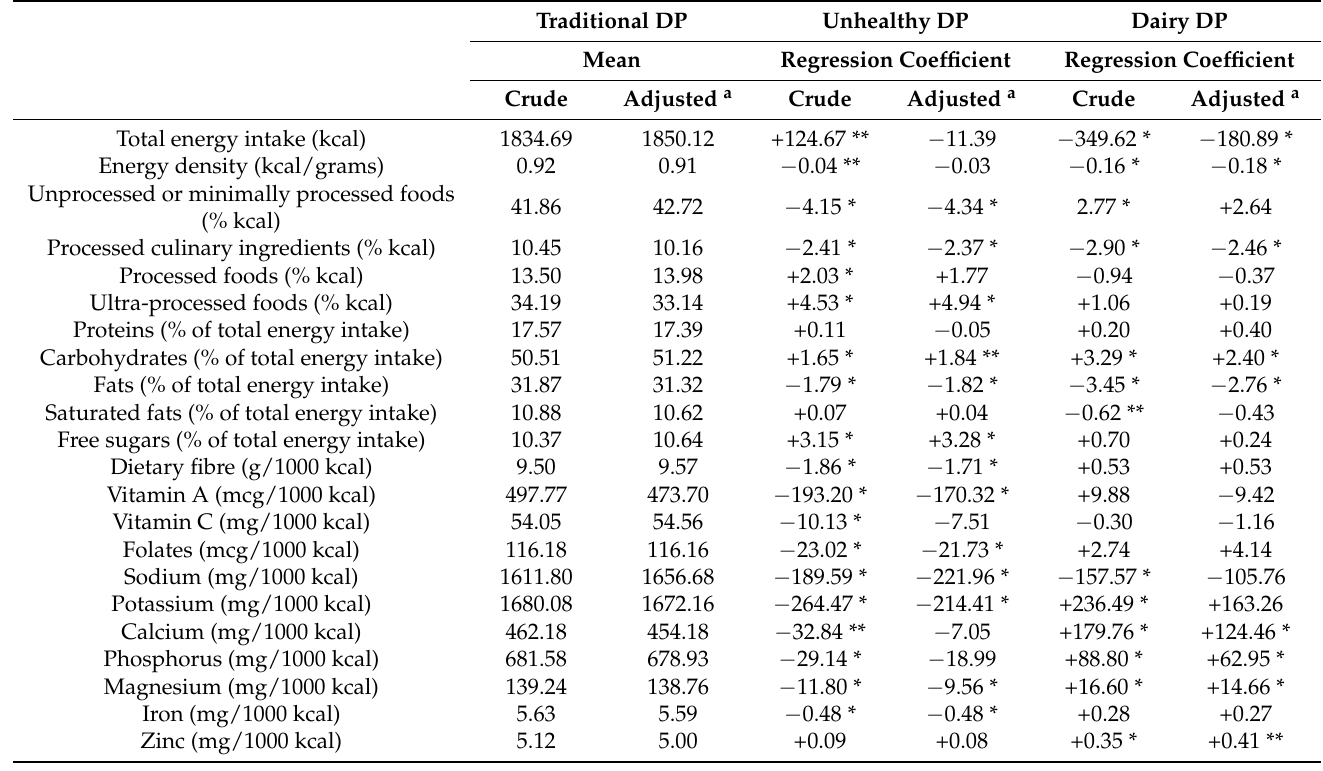
Table 4. Nutritional intake according to dietary patterns derived by latent class analysis among Portuguese population aged 3–17 years: The UPPER